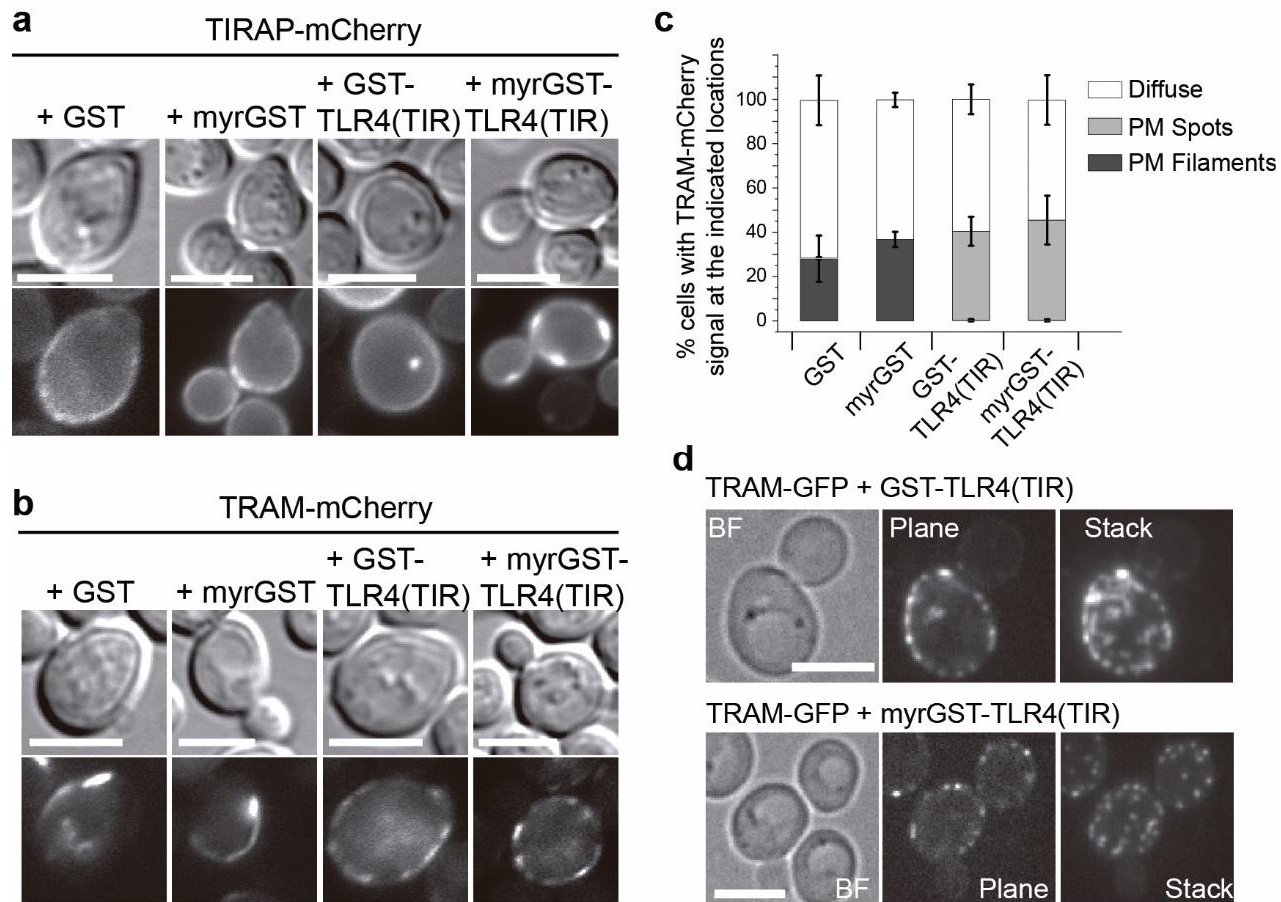
Figure 4. TLR4(TIR) relocates TIRAP and impairs TRAM filament formation. Differential interference contrast and fluorescence microscopy of YPH499 yeast cells co-transformed with pEG(KG) derivatives expressing bare [GST] or myristoylated GST [myrGST], bare [GST-TLR4-(TIR)] or myristoylated [myrGST-TLR4(TIR)] GST fusion to TLR4(TIR) together with TIRAP-mCherry from pYES3 ( a ) or TRAM-mCherry from pYES3 ( b ). Cultures were grown on SR lacking not only uracil and tryptophan but also leucine to ensure maximum plasmid copy number in pEG(KG)-derivatives. ( c ) Graph displaying the percentage of cells showing TRAM-mCherry fluorescent signal predominantly as PM filaments (black), or as PM puncta (gray). Data correspond to means ± standard deviation of three independent transformants ( n > 100). ( d ) Bright-field (BF) and confocal microscopy of YPH499 yeast cells co-transformed with TRAM-GFP from YCpLG and either GST-TLR4(TIR) or myr-GST-TLR4(TIR) from pEG(KG) derivative plasmids. Stacks are the Z projection of 15 planes [GST-TLR4(TIR)] or 14 planes [myrGST-TLR4(TIR)] of 0.3 µ m per step. Scale bars correspond to 5 µ m.